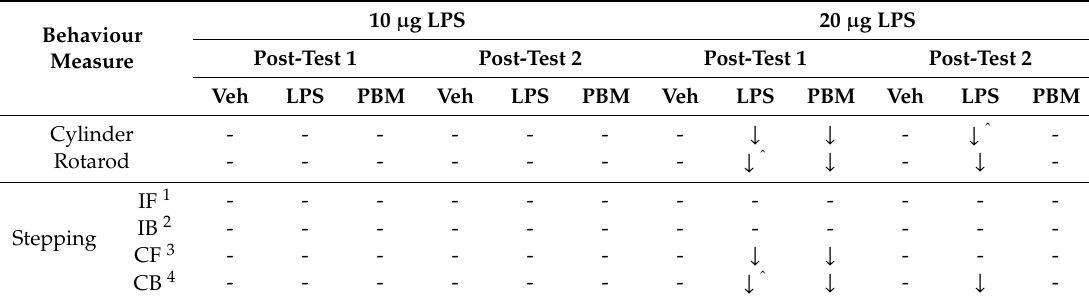
Table 4. A summary of the main behavioural testing results from the 10 µ g and 20 µ g LPS experiments. Arrows represent a significant di ff erence compared to the performance of that group at baseline; hyphens represent no significant di ff erence compared to baseline